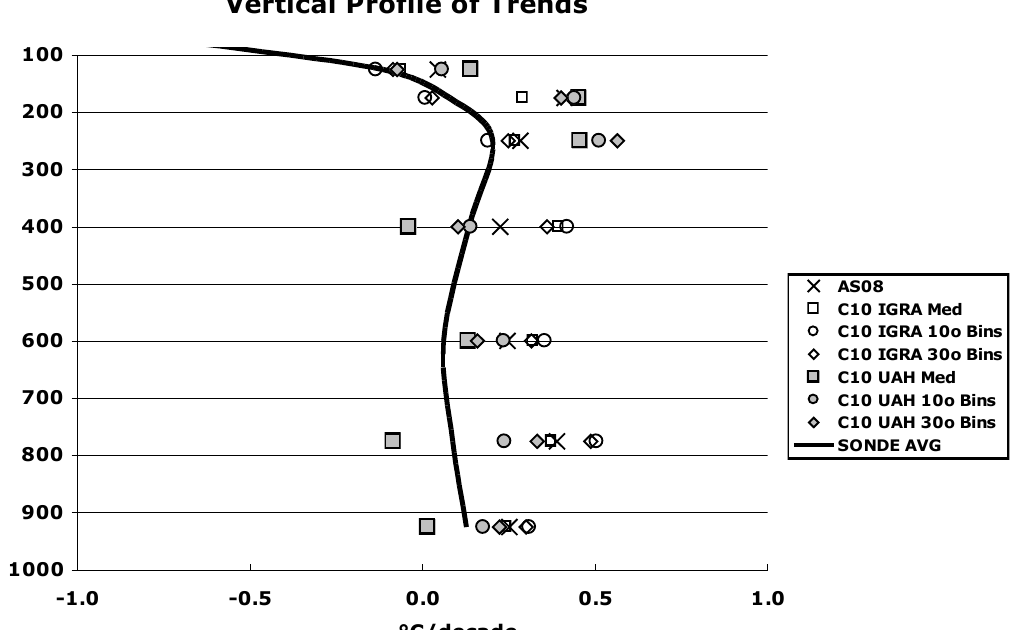
Figure 7. Temperature trend for layers for 1979–2005. Symbols: trends calculated by the thermal wind equation (see text). Line: trends calculated directly from radiosonde temperatures from the average of the 4 radiosonde